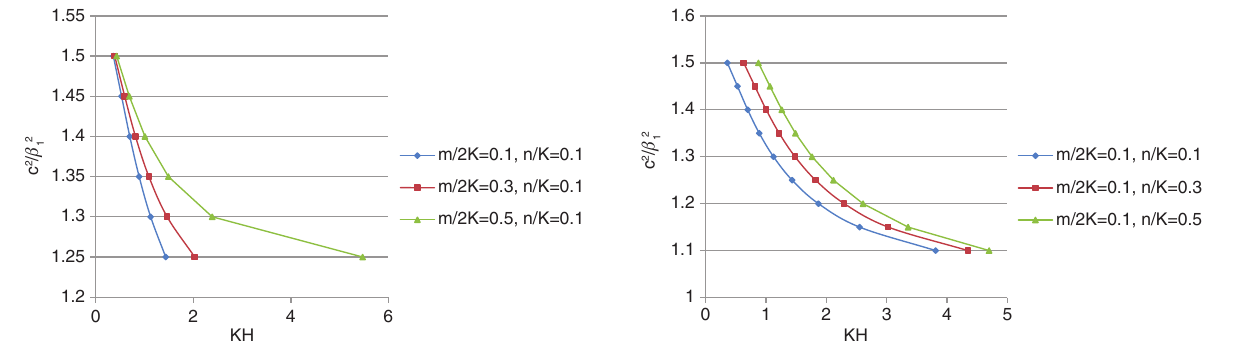
Figure 2: Variation of the dimensionless phase velocity (c/ β against the dimensionless wave number KH, demonstrating the influence of non-homogeneity associated with the monoclinic crustal layer.